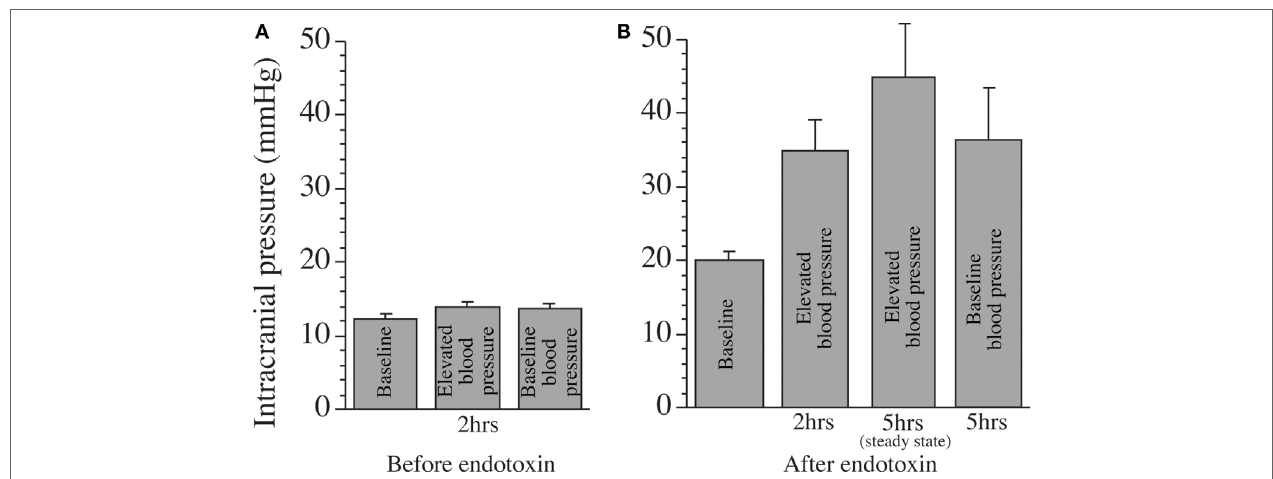
FiGURe 4 | Effects of an increase in mean arterial blood pressure of 30 mmHg, by intravenous infusion of dobutamin and angiotensin II, on intracranial pressure (ICP) in the cat. (A) ICP with intact blood–brain barrier (BBB) with normal arterial blood pressure (baseline) and after 2 h of elevated blood pressure (by about 30 mmHg). ICP was not affected by the increase in blood pressure after 2 h and after 5 h (5-h data are not shown). There was no change in ICP when mean arterial pressure returned to baseline. (B) ICP after disruption of the BBB with intrathecal endotoxin infusion at normal arterial blood pressure (baseline) and after 2 and 5 h with increased mean arterial blood pressure by about 30 mmHg. There was a significant increase in ICP by about 25 mmHg from the increase in arterial pressure. ICP was slightly reduced shortly after the arterial blood pressure returned to baseline, an effect most likely due to a decrease in intracranial blood volume. As can be seen, this effect was smaller from a normal ICP (A) than from a higher ICP (B) , due to the unlinear pressure–volume curve for the brain. Reproduced from Ref. (35), with